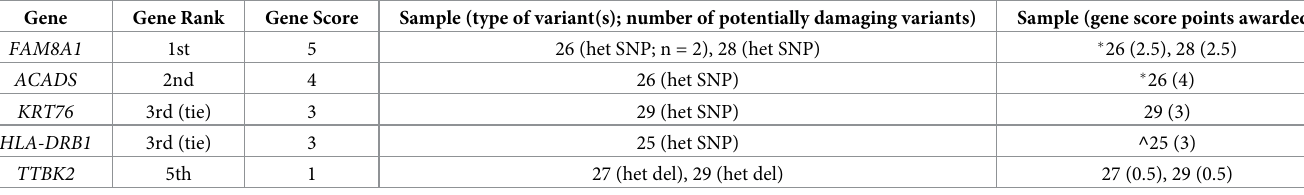
We ranked genes based on the average gene-disease connection and disease likelihood scores (S2 Table). The gene scores were equally divided among the samples when more than one sample shared a variant in that gene.